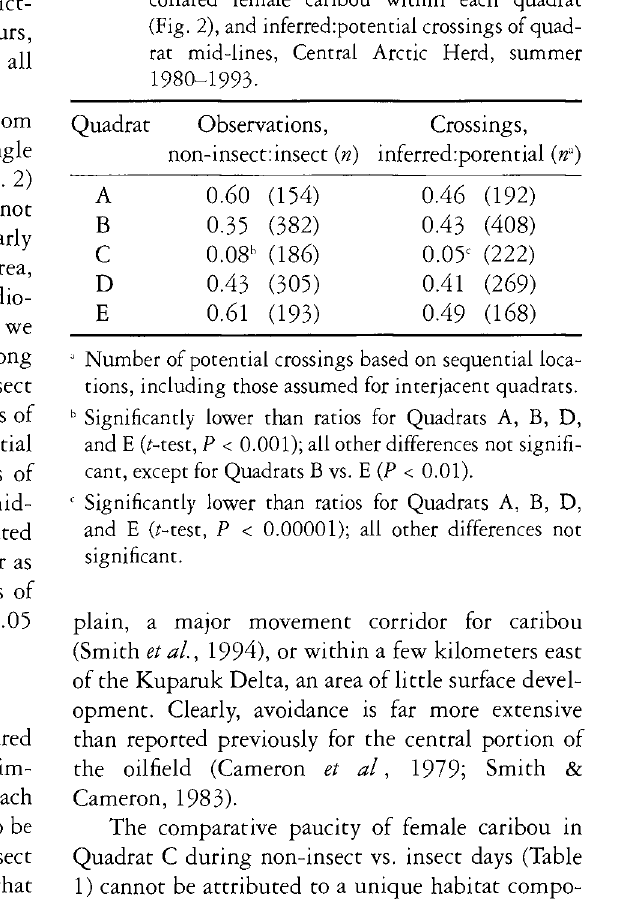
Table 1. Ratios of non-insect:insect observations of radio collared female caribou within each quadrat (Fig. 2), and inferred:potential crossings of quad rat mid-lines, Central Arctic Herd,